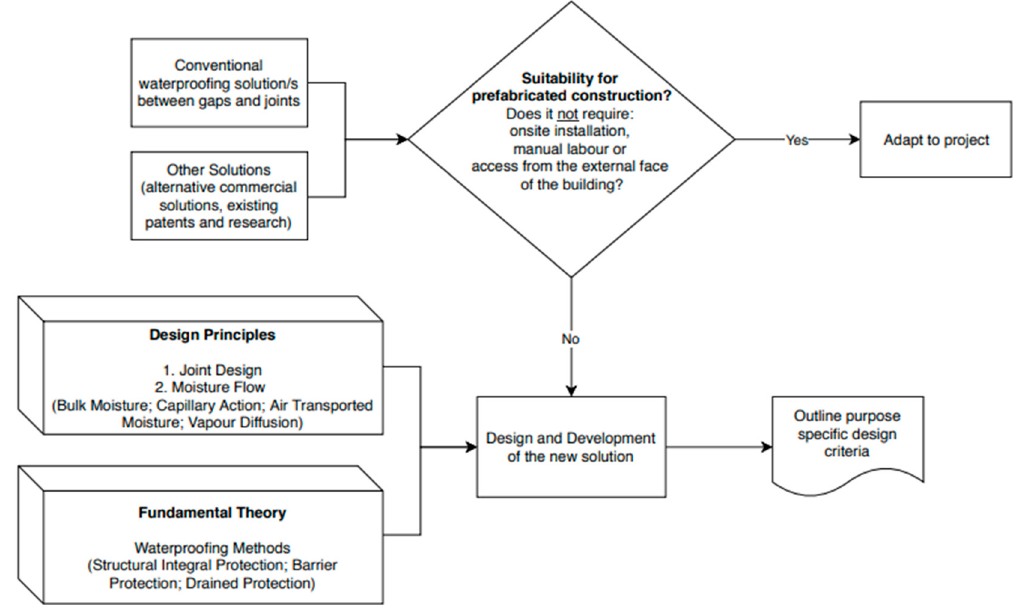
Figure 1. Evaluating the need for design and development of new solutions.